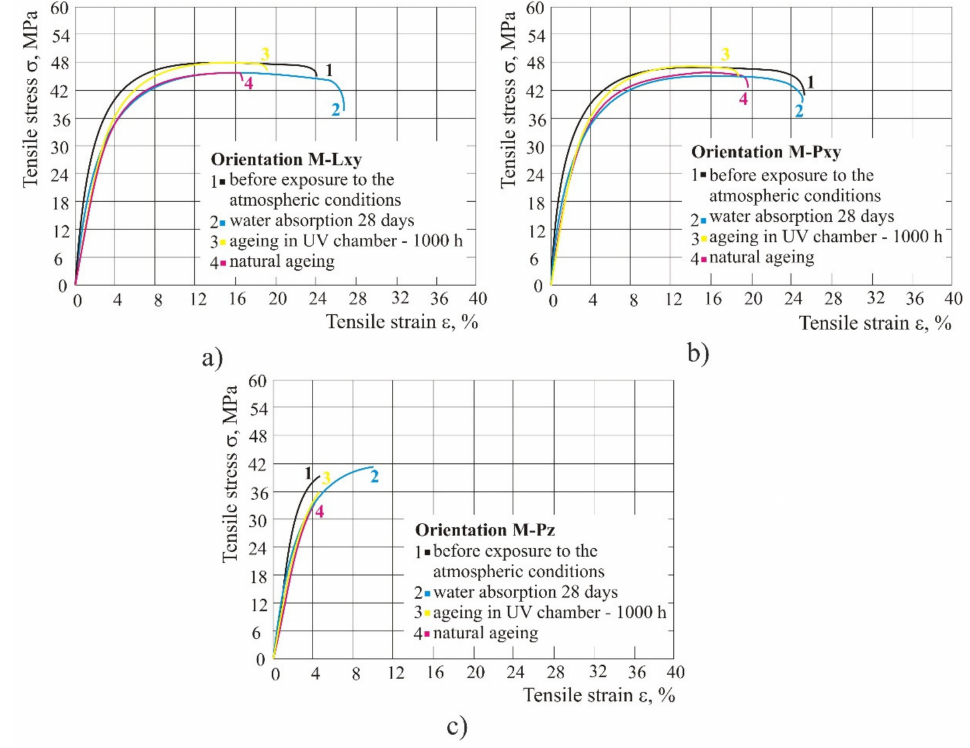
Figure 8. Impact of different weathering conditions on mixed material: ( a ) orientation Lxy, ( b ) orientation Pxy, ( c ) orientation